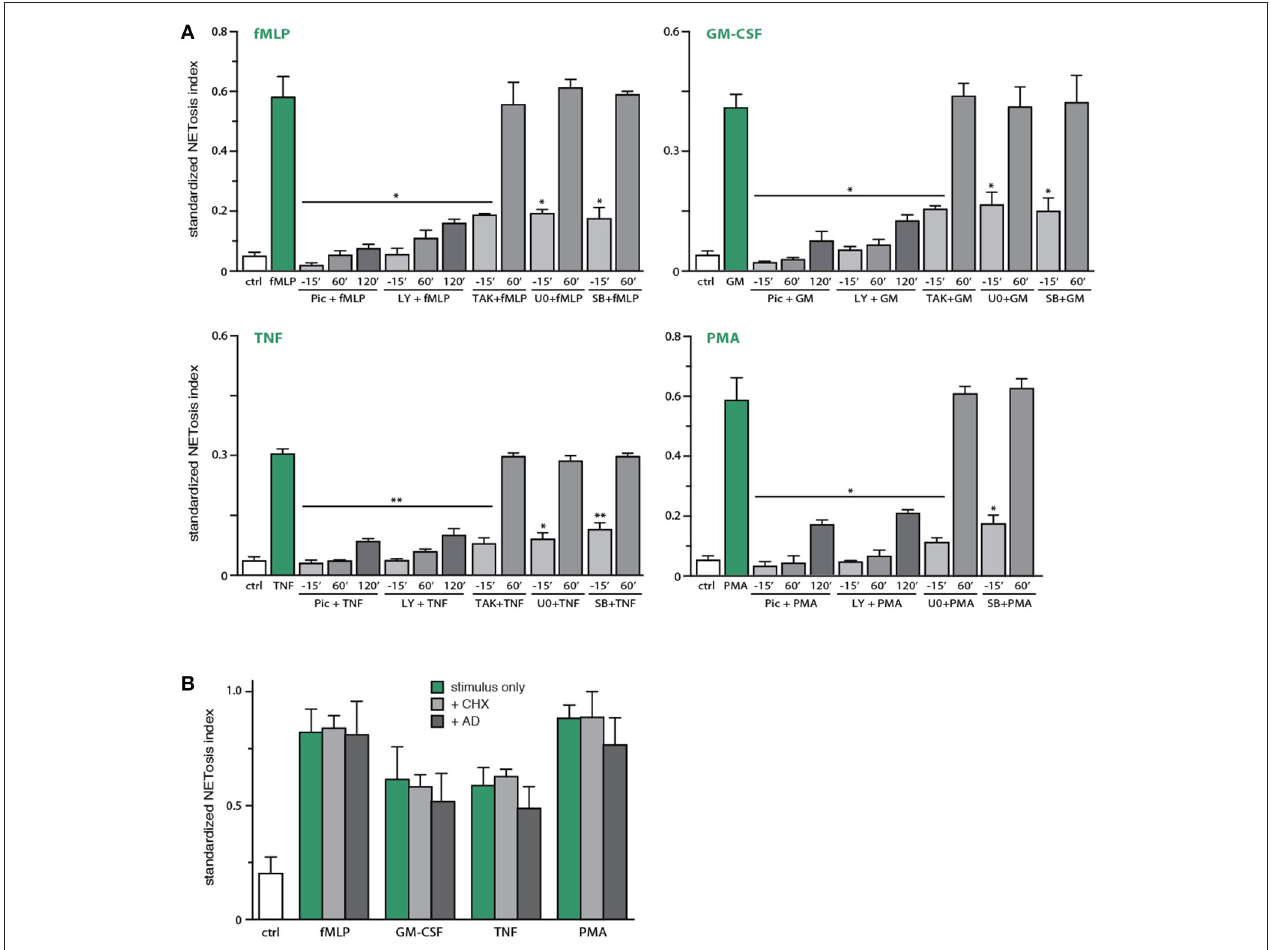
FIGURE 5 | Identification of early and late processes underlying NET generation. (A) Neutrophils cultured on poly-L-lysine-coated coverslips were treated either before or after stimulation for the indicated times with the following inhibitors or their diluent (DMSO): 10 µ M piceatannol (“pic,” Syk inhibitor); 10 µ M LY294002 (PI3K inhibitor); 1 µ M (5Z)-7-oxozeaenol (TAK1 inhibitor); 1 µ M SB202190 (p38 MAPK inhibitor); 10 µ M U0126 (MEK inhibitor). The cells were also stimulated for 4h in the absence (“ctrl”) or presence of 30nM fMLP, 1nM GM-CSF, 100 U/ml TNF α , or 50nM PMA. NETosis was then assessed using PlaNET Green as described